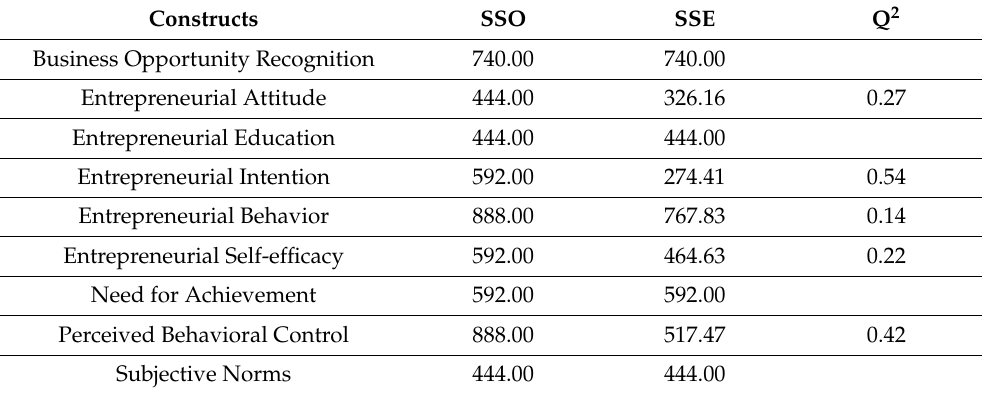
Table 4. Predictive relevance.